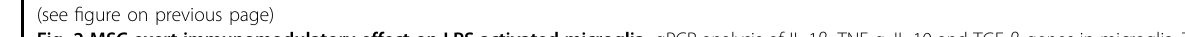
Fig. 2 MSC exert immunomodulatory effect on LPS activated microglia. qPCR analysis of IL-1 β , TNF- α , IL-10 and TGF- β genes in microglia. The expression of each gene was calculated by normalization to GAPDH. Data are presented as mean ± SEM. ** p < 0.01; LPS group compared to NM group. § p < 0.05; NM + MSC lot1 group compared to the NM group. # p < 0.05; LPS + MSC lot1 group compared to the LPS group. †† p < 0.01; LPS + MSC lot2 group compared to the LPS group. ‡‡ p < 0.01, ‡ p < 0.05; LPS + MSC lot3 group compared to the LPS group (unpaired t-test and One-way ANOVA followed by Sidak ’ s multiple comparisons test for IL-10, and Mann – Whitney U -test and Dunn ’ s multiple comparisons test for IL-1 β , TNF- α and TGF- β were used) ( a ). Western blotting results of NF κ B, pNF κ B, iNOS and Arg1. GAPDH was used as an internal control ( b ). Quanti fi cation of Western blotting. Data are presented as mean ± SEM with * p < 0.05 (One-way ANOVA followed by Sidak ’ s multiple comparisons test for iNOS and Dunn ’ s multiple comparisons test for Arg1, pNF κ B and NF κ B were used) ( c ). Immunocytochemistry of microglia stained with Iba-1 (white), CD86 (red), CD206 (green), and Hoechst 33342 (blue) (scale bar = 20 μ m) ( d ). FACS analysis of microglia using CD86 and CD206 markers ( e ). Quanti fi cation of CD86 positive cells ( f ), and CD206 positive cells ( g ). Data are presented as mean ± SEM (One-way ANOVA followed by Sidak ’ s multiple comparisons test for CD206, and Dunn ’ s multiple comparisons test for CD86 were